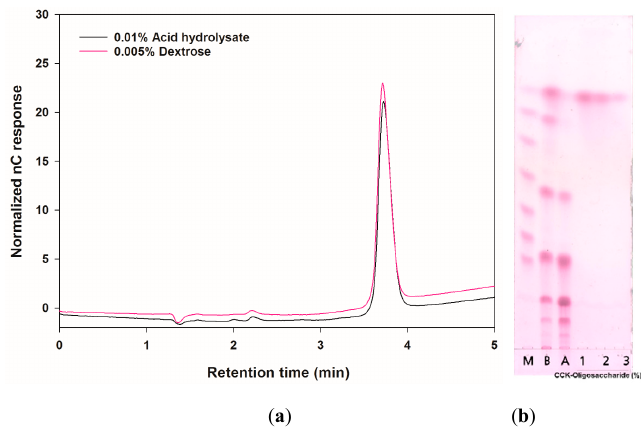
Figure 1. High-performance anion exchange chromatography with pulsed amperometric detection (HPAEC-PAD) and thin-layer chromatography (TLC) chromatograms of CCK-oligosaccharide (produced by L. lactis CCK940) acid hydrolysate. ( a ) HPAEC-PAD chromatogram of 0.005% ( w / v ) dextrose and 0.01% acid hydrolysate. ( b ) TLC chromatograms obtained before and after purification of CCK-oligosaccharides and acid-hydrolyzed CCK-oligosaccharides (M: glucose polymers G1–G7; B: before purification; A: after purification by Bio-gel P2; 1: 1% of acid hydrolysate; 2: 0.5% of acid hydrolysate; 3: 0.2% of acid